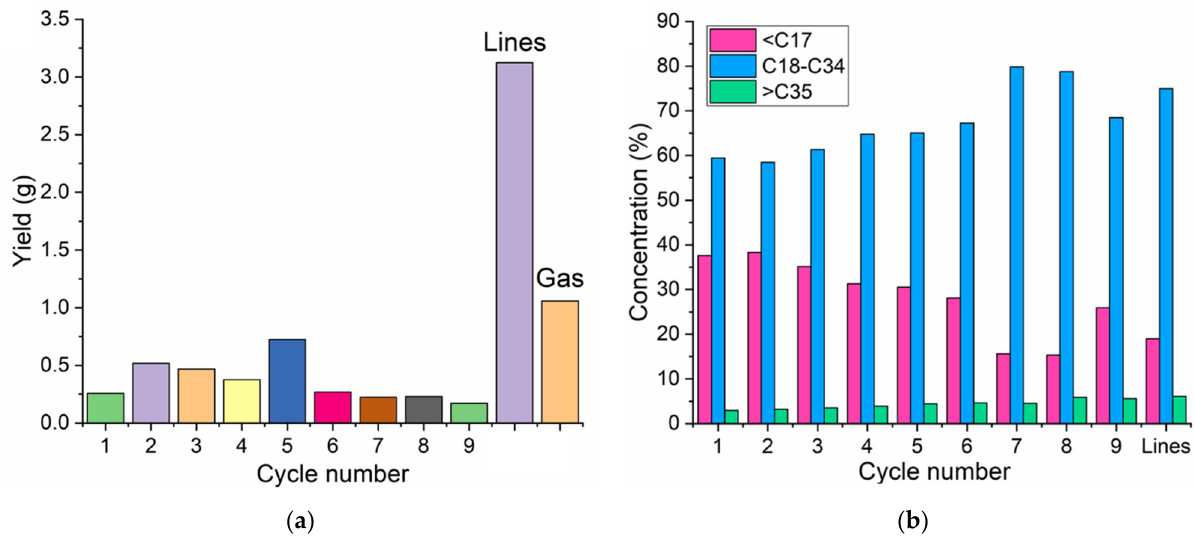
Figure 4. (a) Hydrocarbons yield during the experiment; (b) SimDis distribution of produced liquid hydrocarbons.